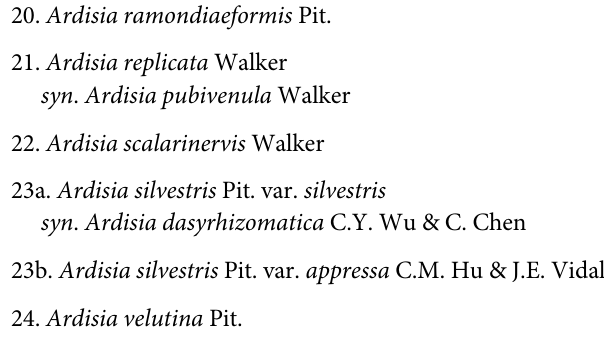
S1 Fig. Maximum likelihood (ML) phylogeny of Ardisia and allies based on plastid psbA- trnH and rpl32-trnL sequences. Numbers at branches are ML bootstrap support values. S2 Fig. Maximum likelihood (ML) phylogeny of the 16S rRNA sequence for Burkholderia sensu lato . Numbers at branches are ML bootstrap support values and Bayesian posterior probabilities. ML bootstrap support values are indicated only if at least 50, and the Bayesian posterior probabilities are indicated only if at least 0.7. Alternative branching between the two different analyses was shown as no support at the branch. S3 Fig. Maximum likelihood (ML) phylogeny of the 16S-23S rRNA sequence for the Ardi- sia symbionts. Numbers at branches are ML bootstrap support values. ML bootstrap support values are indicated only if at least 50. S4 Fig. Tanglegram for leaf-nodulated Ardisia and their symbiotic bacteria. Results from distance-based analysis using TreeMap are shown. Symbiont species (yellow, right) are con- nected to their host (blue, left) by gray lines. Maximum likelihood trees are based on the nrITS and plastid sequences ( psbA-trnH and rpl32-trnL ) for the host (left) and the 16S-23S rRNA of their symbiotic bacteria (right). Outgroups were removed here. Significant nodes are shown in red and the degree of significance is shown by the intensity of